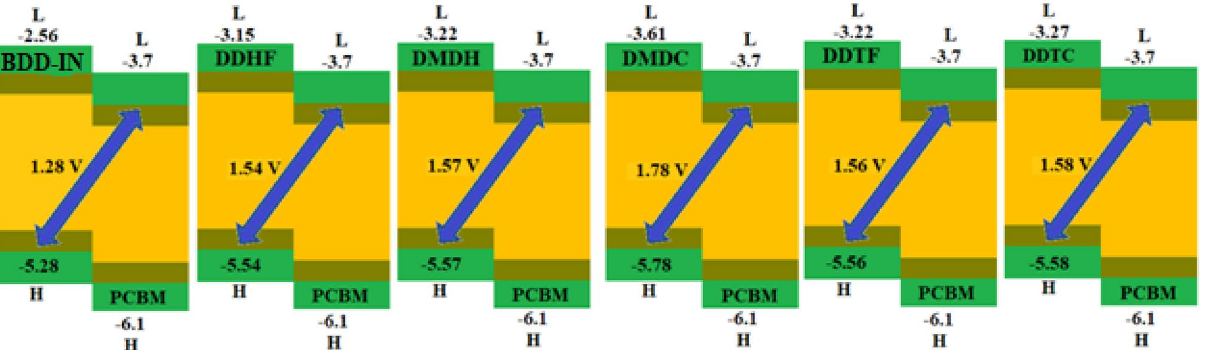
Figure 7. Graphical representation of Voc for studied compounds. All out put files of the designed compounds were accomplished by Gaussian 09 version D.01 (https:// gauss ian. com/ g09ci voltage that can be gained at zero current value from any device. Voc depends on numerous features: external fluorescence proficiency, charge carrier recombination, light source, temperature of OSCs device, light inten- sity, and different environmental features. Principally, Voc relies on the saturation current and light generation that assists the recombination in the devices. Voc is approximately proportional to (cid:31) E of donor and acceptor molecules corresponding to HOMO donor –LUMO PC61BM energies. In the current quantum chemical evaluation, Voc values are calculated by utilizing acceptor molecule (PC 61 BM). The Voc of PC 61 BM is variable and depends completely on the electron donating compound. Theoretically the calculated results of Voc for the OSCs have been with the aid of Eq. (1), established by Scharber and his co-workers 47 .